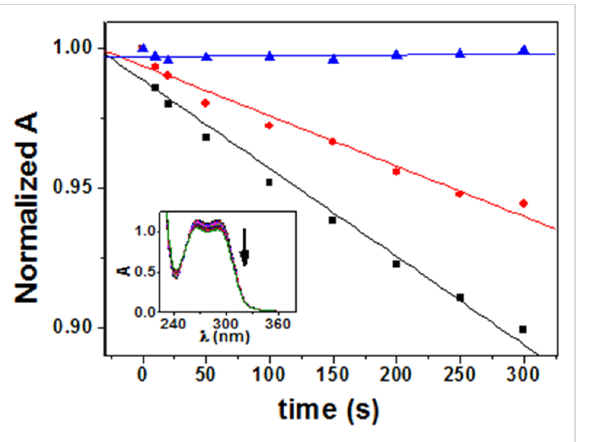
Figure 5: Decrease of the absorbance at 290 nm upon irradiation in CH 2 Cl 2 under N 2 for 1 (red circles), 2 (black squares) and 3 (blue trian- gles) as a function of the irradiation time. Inset: changes in the absorp- tion spectrum of a deaerated dichloromethane solution of 1 after in- creasing irradiation times with monochromatic light at λ = 266 nm. Dyads 1 and 2 were efficiently photolyzed under anaerobic conditions, whereas 3 was markedly unreactive. Interestingly, 2 was significantly more photoreactive than 1 indicating a clear stereodifferentiation in the photochemical behavior.